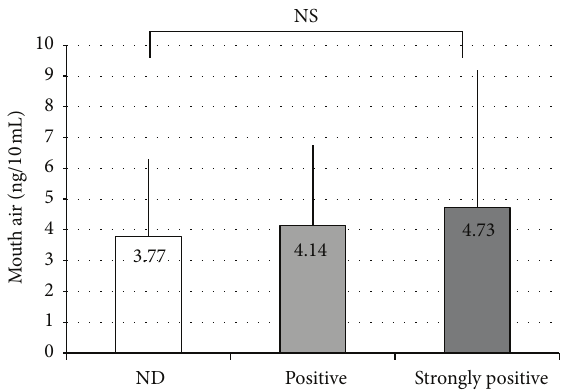
Figure 2: Correlations between the total VSCs measurements and Candida culture test results. NS: not significant. Vertical line: SD. Statistical comparison was performed using unpaired 𝑡 -tests.